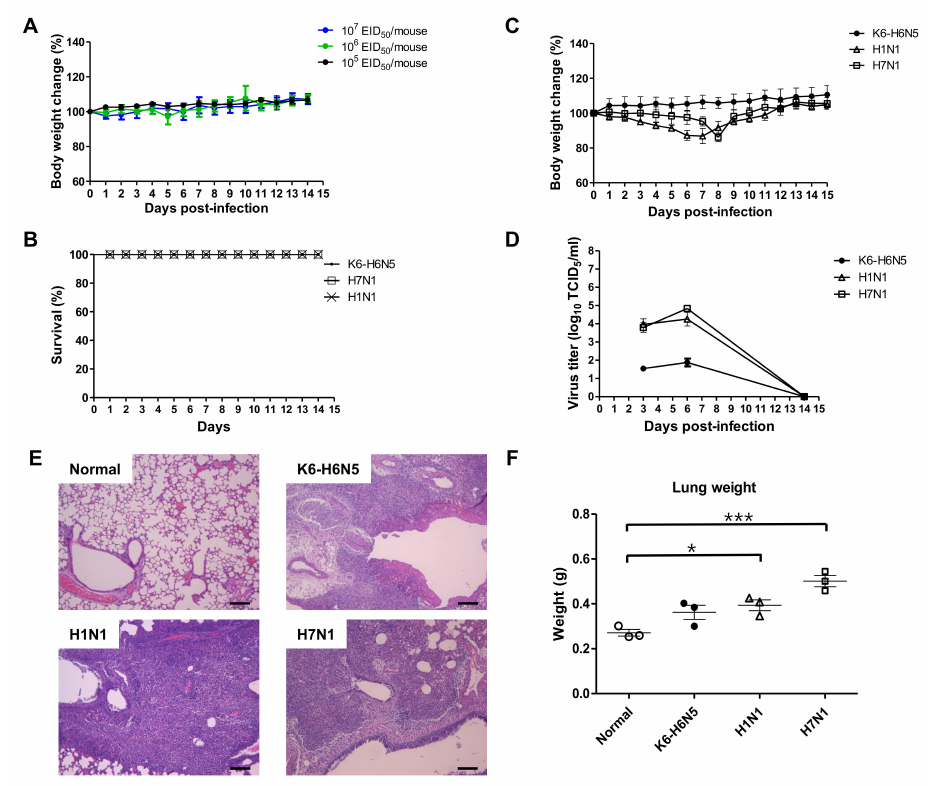
Figure 3. Pathogenicity of K6-H6N5 virus in vivo. ( A ) Balb / c mice were intranasally challenged with different titers of the K6-H6N5 isolate. ( B – F ) H1N1 and H7N1 strains were used as controls, administered intranasally with 10 5 EID 50 . Mouse weight ( B ) and survival rate ( C ) were observed for 14 dpi. Body weight is presented as % of those of original mice ( n = 10). ( D ) Mean viral titers in the lungs of mice ( n = 3) were measured at 3, 6, and 14 dpi. ( E , F ) Histology of lung inflammation following virus infection was observed. ( E ) H&E staining of uninfected control (normal); H6N5; H1N1; H7N1-infected mouse lungs at 6 dpi (scale bar, 100 µ m; original magnification, 100 × ). ( F ) Mean of lungs weight from an uninfected control (normal) and H1N1-, H7N1-, and H6N5-infected mice at 6 dpi ( n = 3). *, p < 0.05; ***, p < 0.001